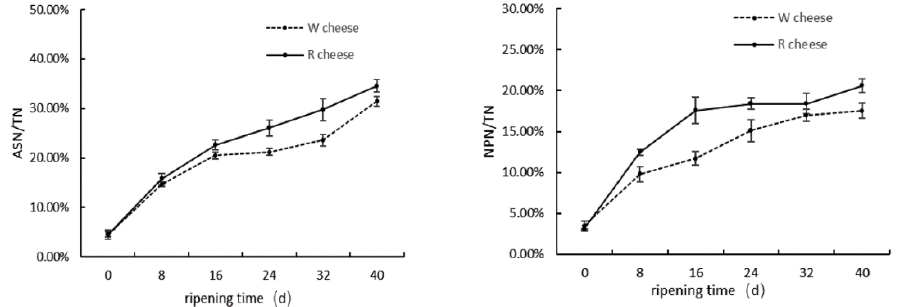
Figure 1. Changes of ASN/TN and NPN/TN of two cheeses with different ripening time. The concentration of individual free amino acids (FAAs) in cheeses was affected by the processing, type, and degree of proteolysis, ripening time and conditions, etc. [11]. FAA content in both cheeses increased obviously as the ripening time (Figure 2) and correlated with the results of the proteolysis due to the fact that the addition of Monascus promoted the hydrolysis of protein in Camembert-type cheeses. Aspartic, Threonine, Glutamic, Glycine, Methione, Isoleucine, Phenyalanine, and Lysine contents in R cheese were significantly higher than those in W cheeses. FAAs contribute to the flavor of cheeses through two pathways. On the one hand, some of the FAAs are tasteful substances. According to their different tastes, FAAs can be divided into five types, I class (acid fresh): Glu, Asp; II class (sweet fresh): Thr, Ser, Gly, Met and Cys; III class (sweet slightly bitter): Pro, Ala; IV class (bitter): Val, Leu, Ile, Phe, and Tyr; V class (bitter slightly sweet): His, Lys, and Arg. The content of the first four classes in R cheeses was